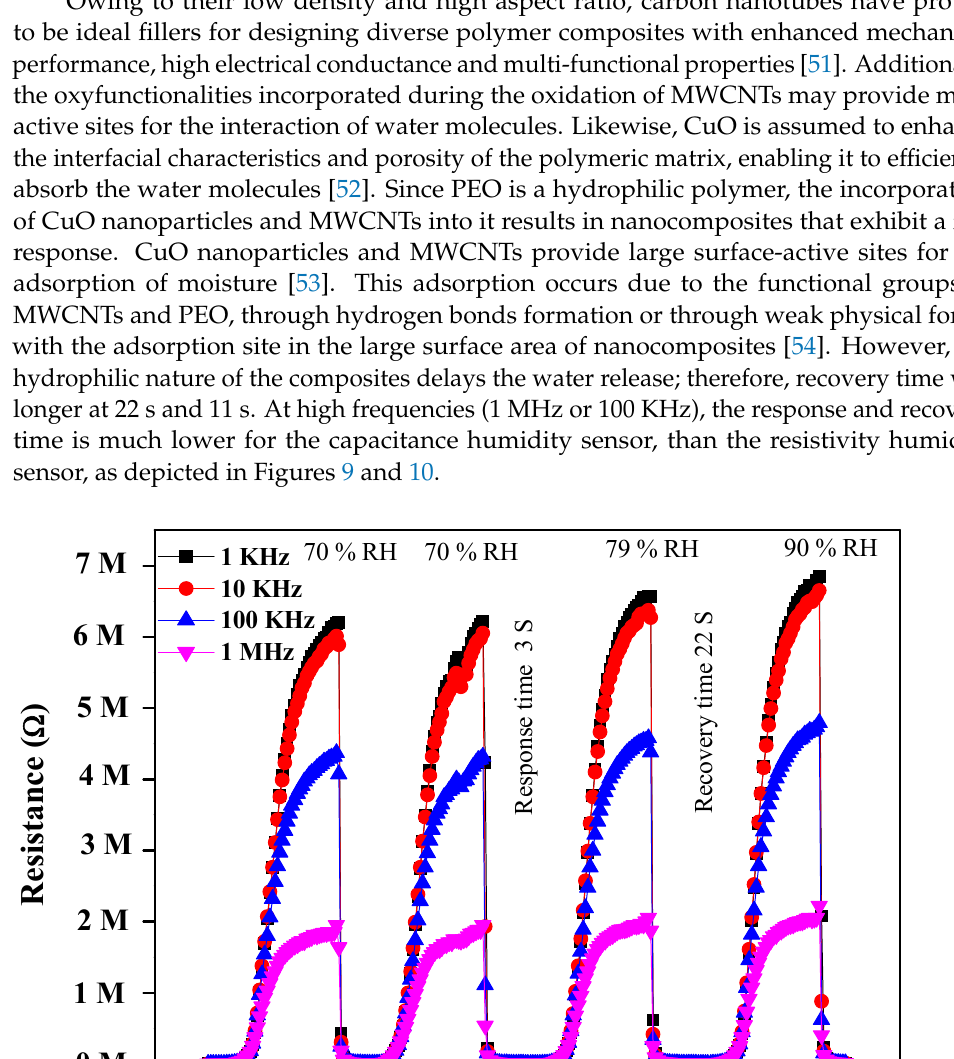
Figure 10. Capacitance response/recovery time for PEO − MWCNT − CuO: 3% nanocomposites. 3.2.3. Humidity Sensing Mechanism